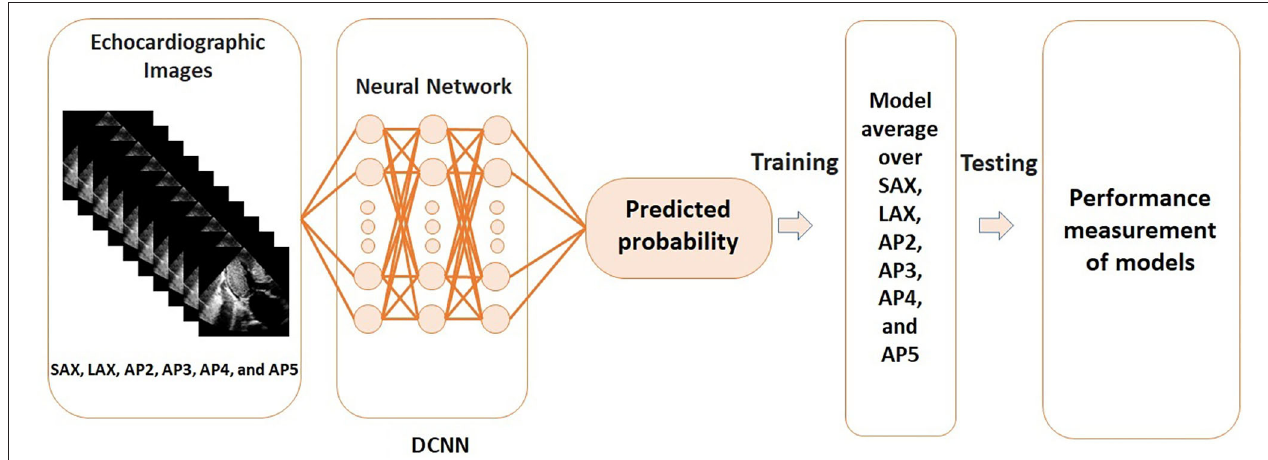
FIGURE 1 | Steps of the deep convoluted neural network analysis using echocardiographic images. DCNN, deep convoluted neural network; AP2, apical 2-chamber view; AP3, apical 3-chamber view; AP4, apical 4-chamber view; AP5, apical 5-chamber view; LAX, parasternal long-axis view; SAX, parasternal short-axis view.